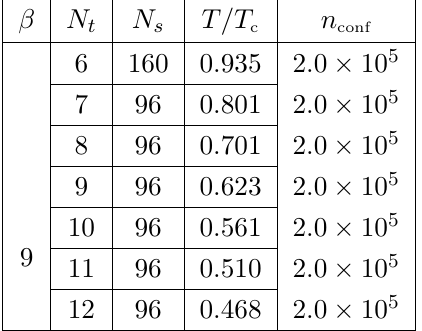
Table 4 . Information on the simulations at β = 9 .